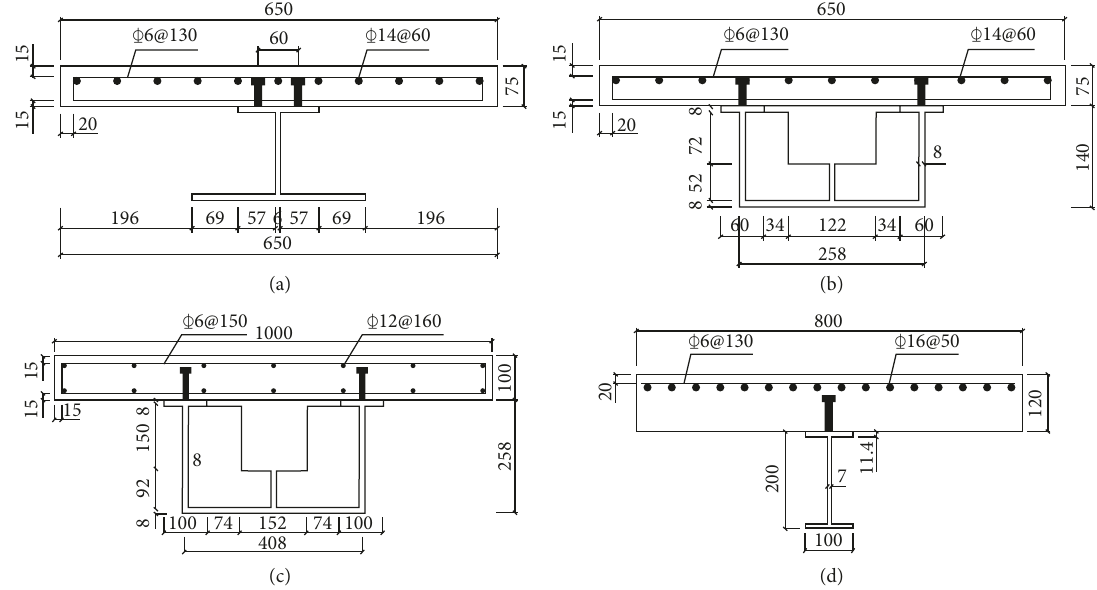
Figure 1: Cross section details of the girders: (a) SCB1 ∼ 2, (b) SCB3 ∼ 8, (c) SCB9 ∼ 13, and (d) SCB14 ∼ 24.